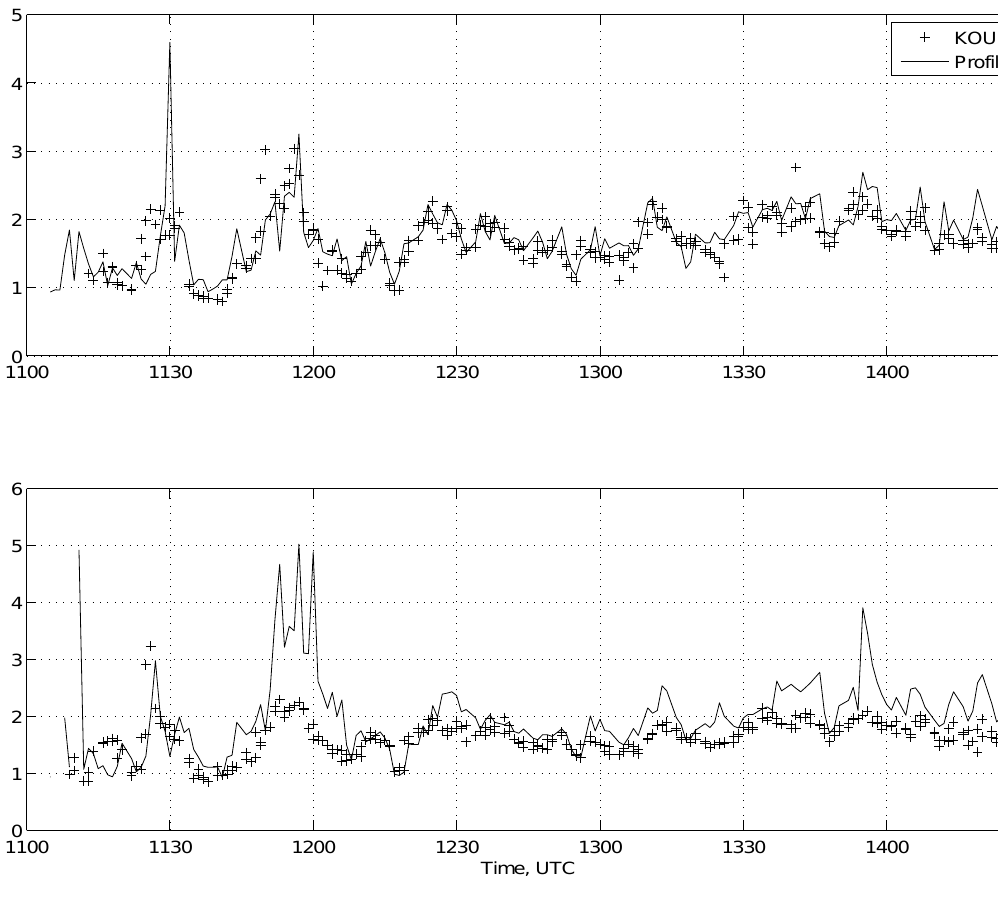
Fig. 5. Time history plots of D m for an exponential DSD retrieved from KOUN and the ARRC profiler during 11 March 2007 rain event at